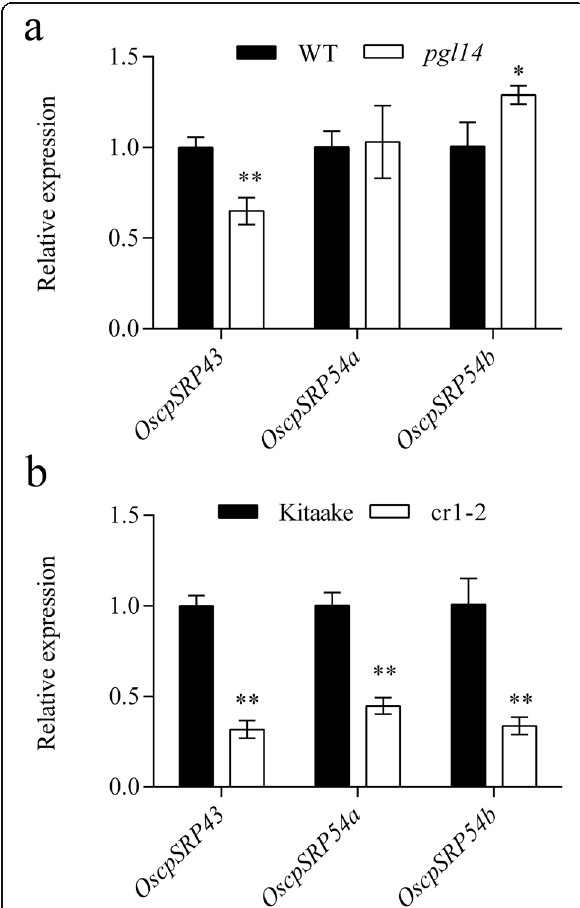
Fig. 8 Differential expression of cpSRP genes. a Transcript levels of cpSRP genes in the wild type IR64 and pgl14 at 3 weeks after sowing. b Transcript levels of cpSRP genes in the wild type Kitaake and cr1 – 2 at 1 week after transplanting. The transcript levels of tested genes are normalized to the levels of Ubq ( LOC_Os03g13170 ). The values are means ± SD ( n = 3). The asterisk indicates the significant difference between the wild type and mutant according to Student ’ s t -test (* p ≤ 0.05; ** p ≤